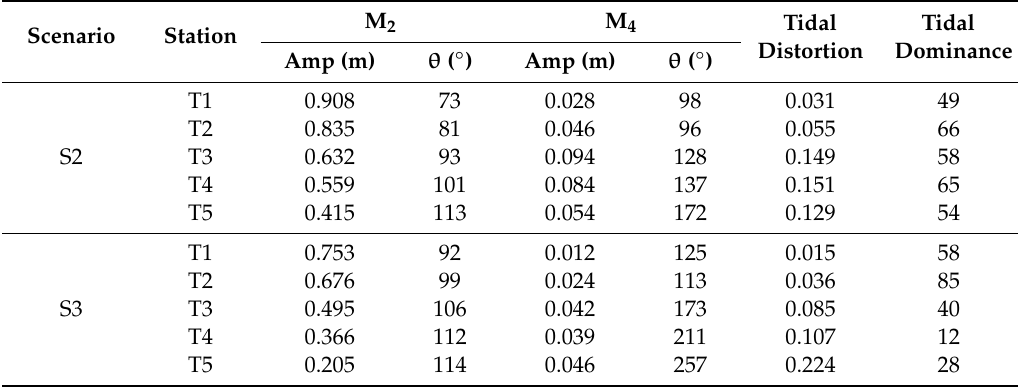
Table 10. Tidal amplitude (amp) and phase ( θ ) of the M 2 and M 4 tidal constituents and tidal distortion and tidal dominance factors for T1 to T5 stations during S2 and S3 scenario